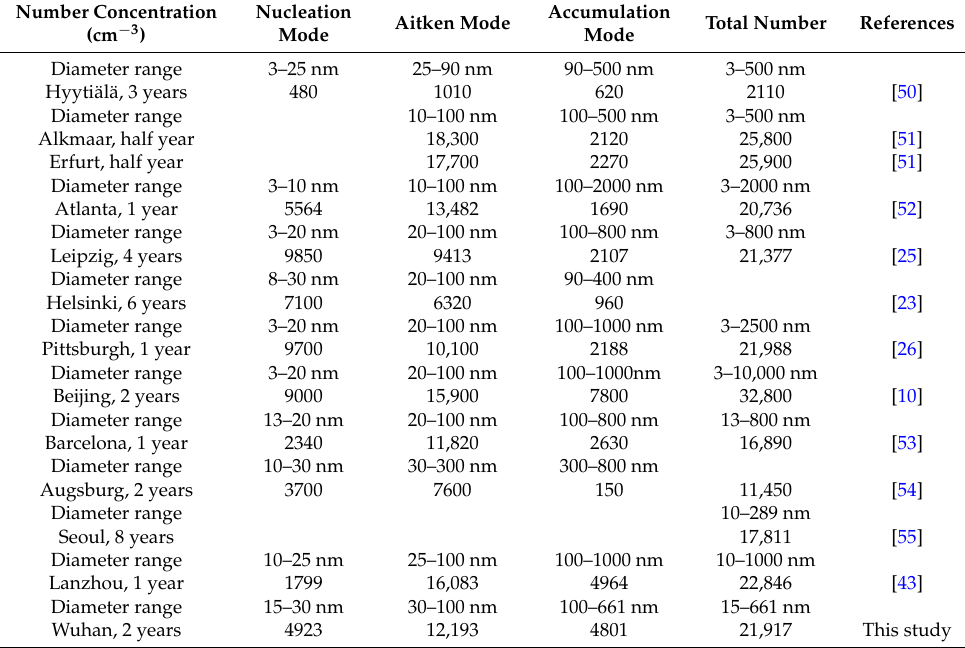
Table 1. Overview of comparisons of particle number concentrations in different locations of the